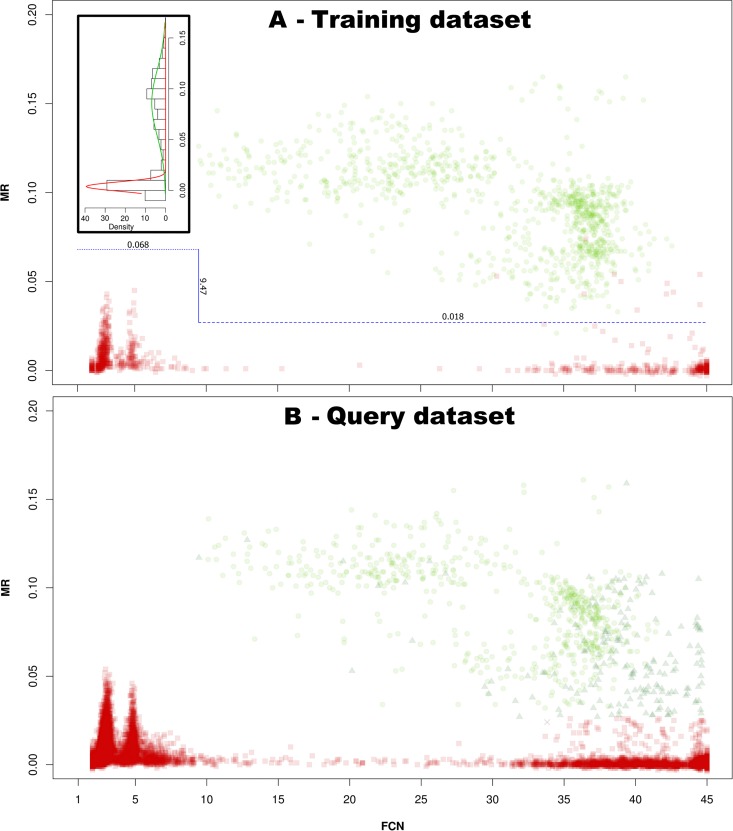
Clustering of TAC results in the FCN-MR plane.A: output of the MR method for the training dataset. Reactions were identified by a consensus classification as either positive (●) or negative (■) and are plotted in the FCN-MR plane, showing the different localization of the two populations. Since early cycles of amplification might be biased by transient in fluorescence that can generate high MR values, two MR cut-offs were applied to separate positive and negative results. For values below the lowest FCN of the positive population (9.47, solid line), 150% of the maximum MR observed in the region was used (0.068, dotted line). Histogram analysis was implemented to obtain MR values that could separate the positive and negative populations (insert). The mid-point between the lowest and highest of these separators was used to discriminate positive and negative results for reactions with a FCN values above the lowest FCN of the positive population (0.018, dashed line). B: the cut-off values empirically obtained by analysing the training dataset were applied to the query dataset in order to identify positive and negative reactions. The results are classifies as true positive (●), true negative (■), false positive (▲) and false negative (×) according to the consensus classification. The FCN axis has units defined in cycles whereas the MR axis is a-dimensional. The x-axis of the insert panel is given in MR values.